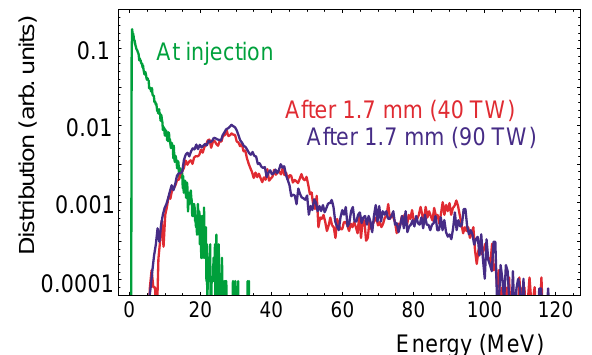
FIG. 17. (Color) Energy distributions of bunches at injection (green) and after 1.7 mm acceleration for the 40 TW case (red) and the 90 TW case (blue). The total charge for the 90 TW case is 9 (cid:3) 4 larger. the spectra: for the 90 TW case, the bunch charge is of course 9 (cid:3) 4 times higher.